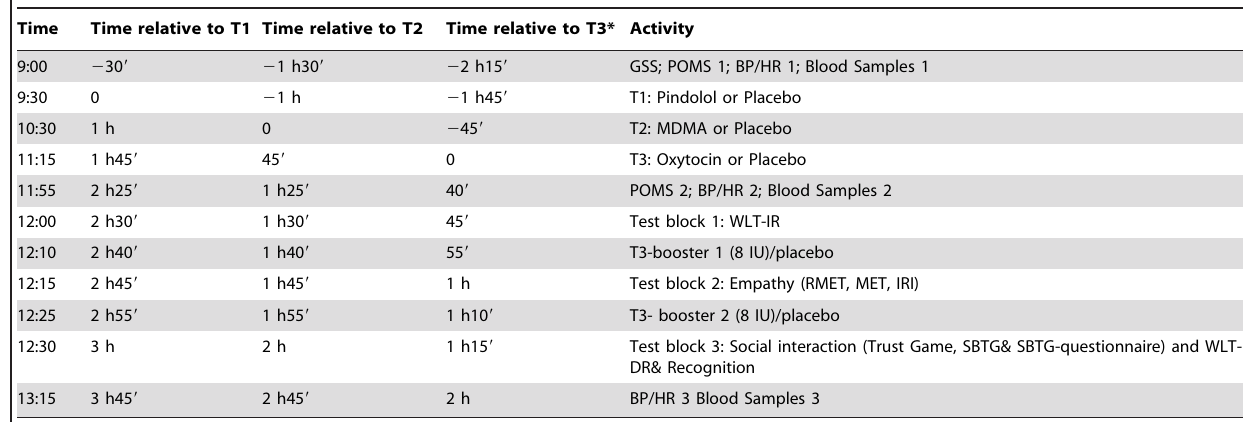
Table 2. Schematic representation of a test day; BP = Blood Pressure, HR = Heart Rate; * T3= first dose of 40 IU.